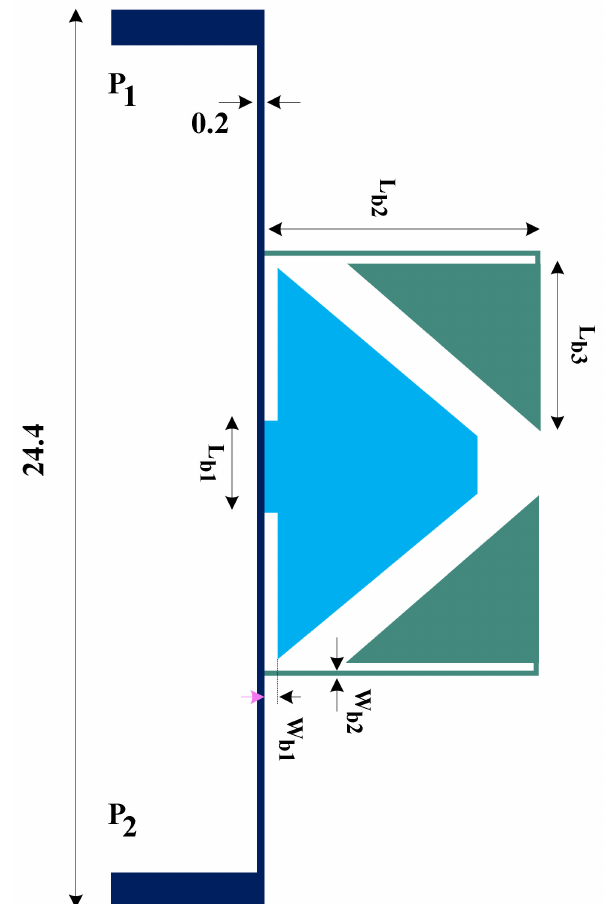
Figure 5. The layout of the proposed vertical resonator.